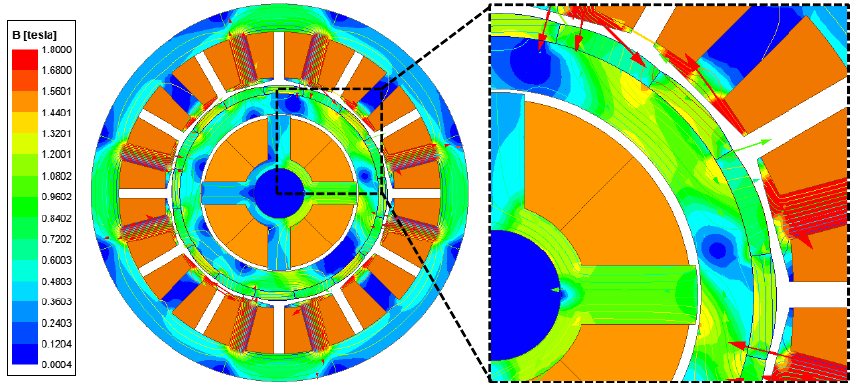
Figure 26. Rotor flux density plot of proposed model.